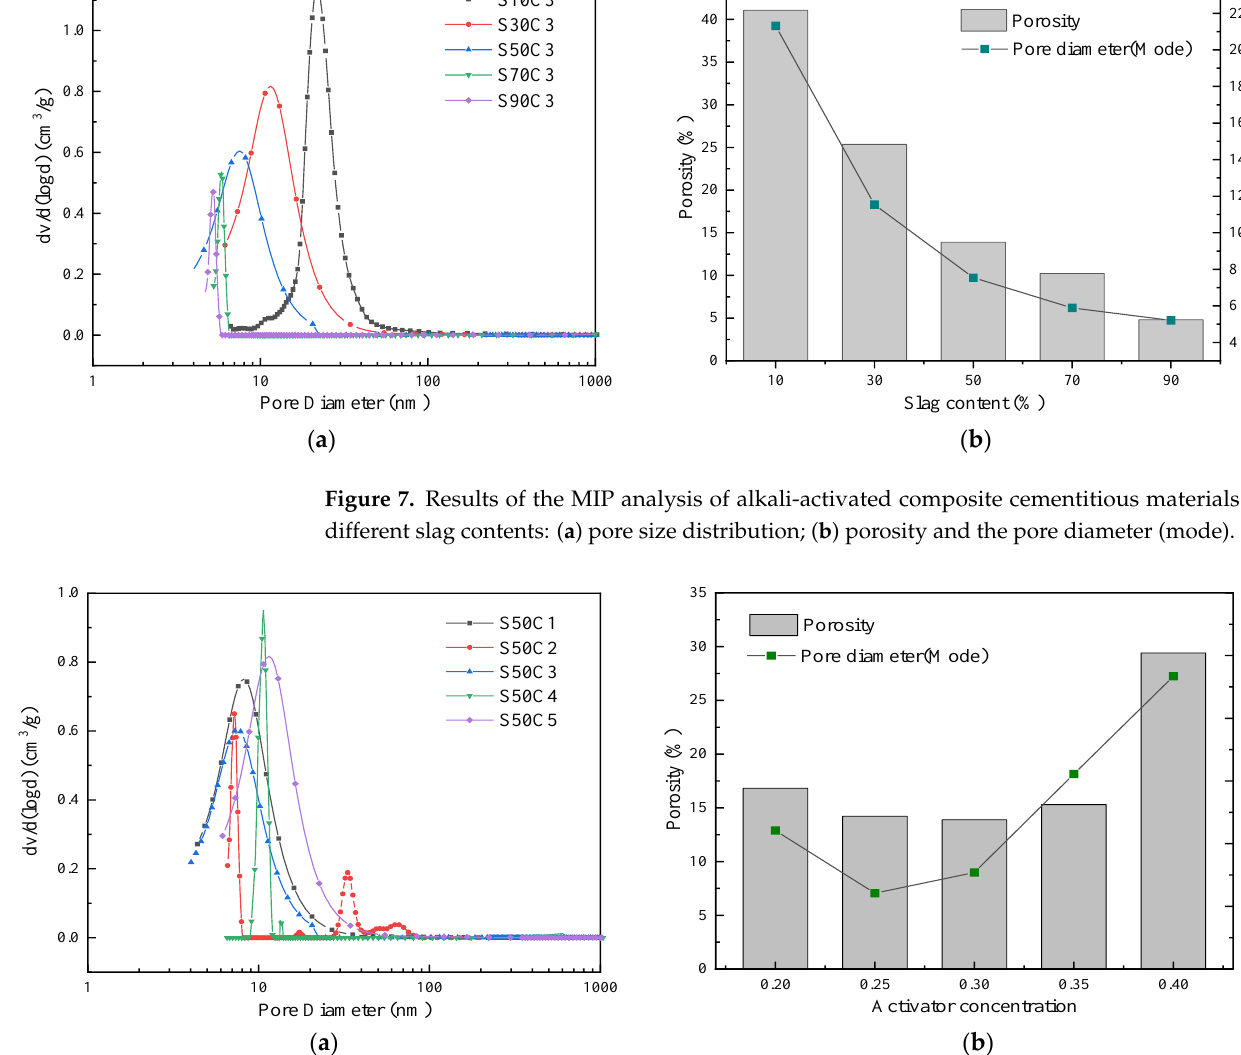
Figure 6. FT-IR spectra analysis of alkali-activated composite cementitious materials: ( a ) slag con- tent; ( b ) activator concentration.